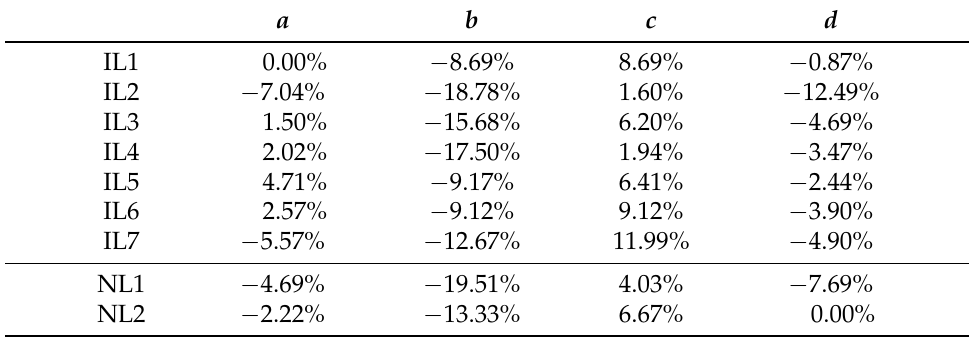
Table 4. Delays and related values for swimmers IL1–IL7 and NL1–NL2: ( a , b , c , d )